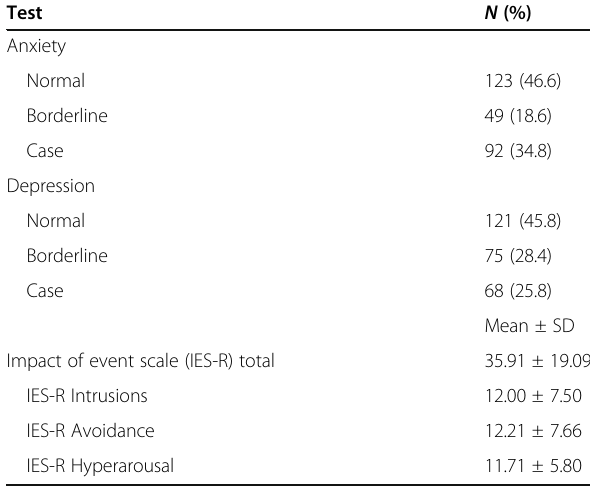
Table 3 Psychological morbidities of the study